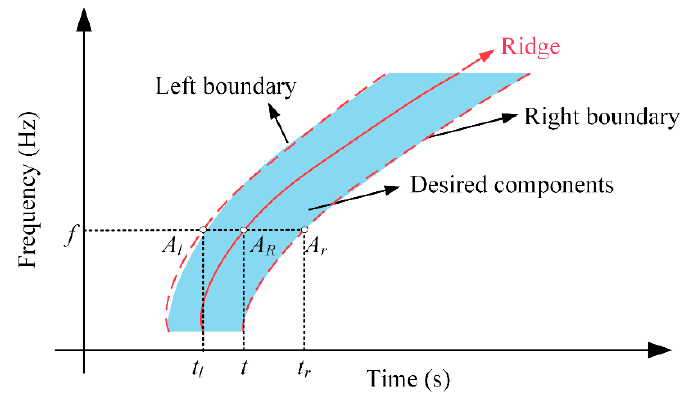
Figure 3. Illustration of ridge and its neighbor area in time-frequency domain.